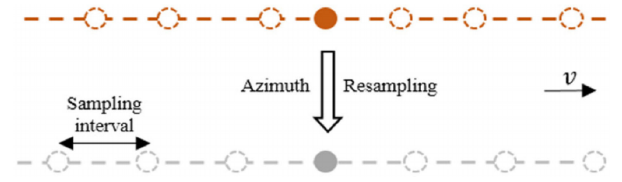
Figure 3. The azimuth resampling diagram.